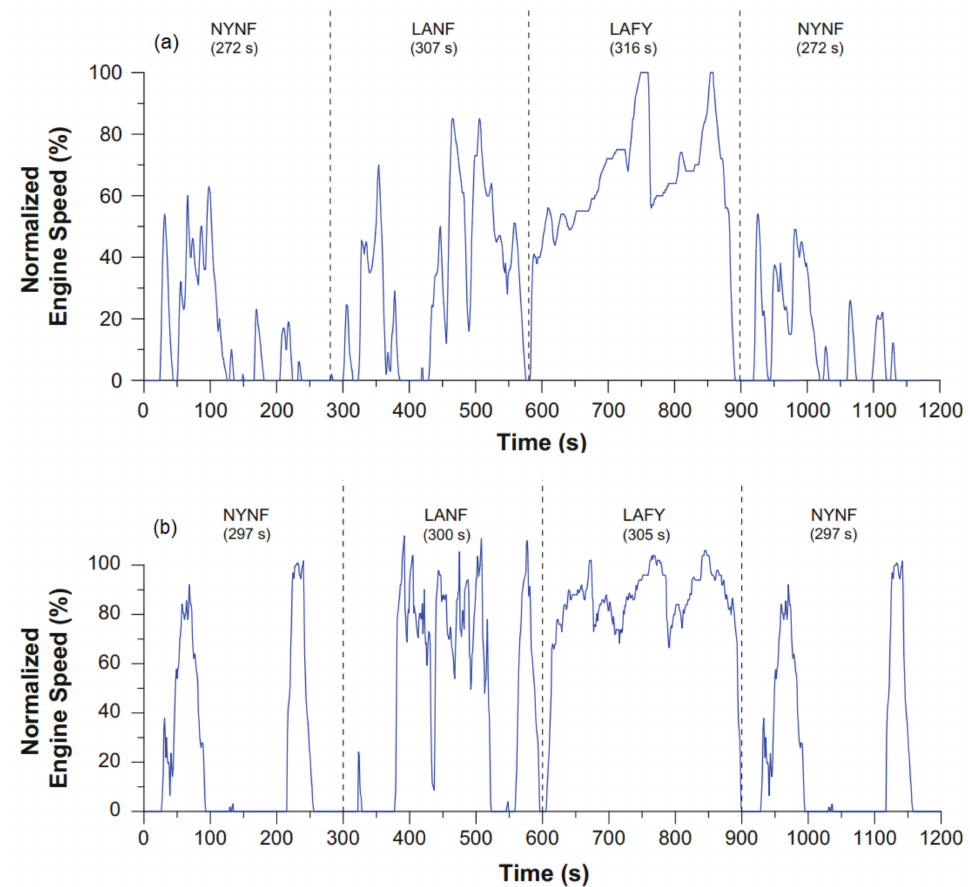
Figure 15. Heavy-duty transient FTP cycles in normalized speed for ( a ) Otto-cycle and ( b ) Diesel-cycle engines (40 CFR 86, App. I).